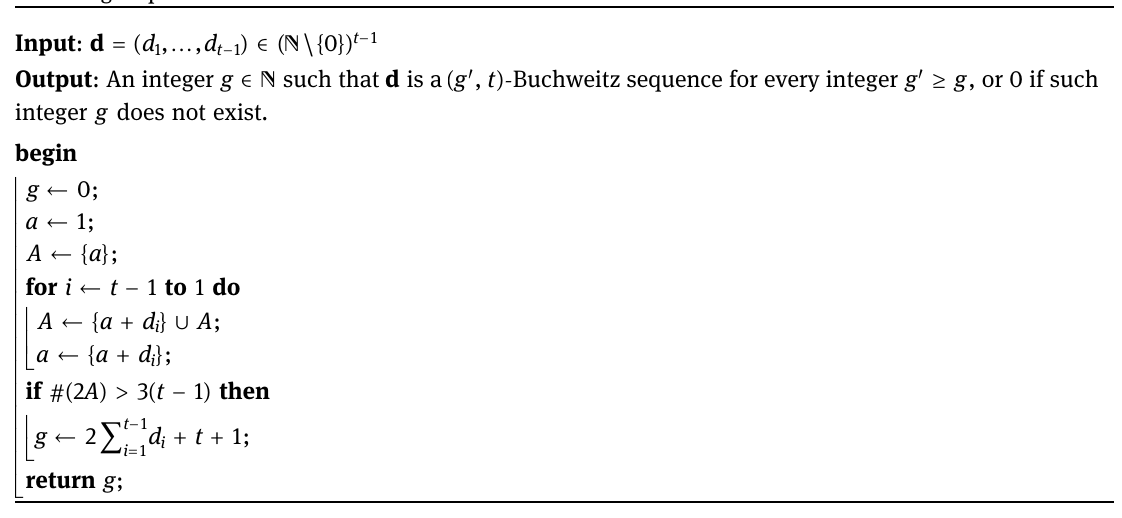
Algorithm 1: Algorithm to check if a di ff erence sequence is the sequence of a family of 2 - Buchweitz PF -